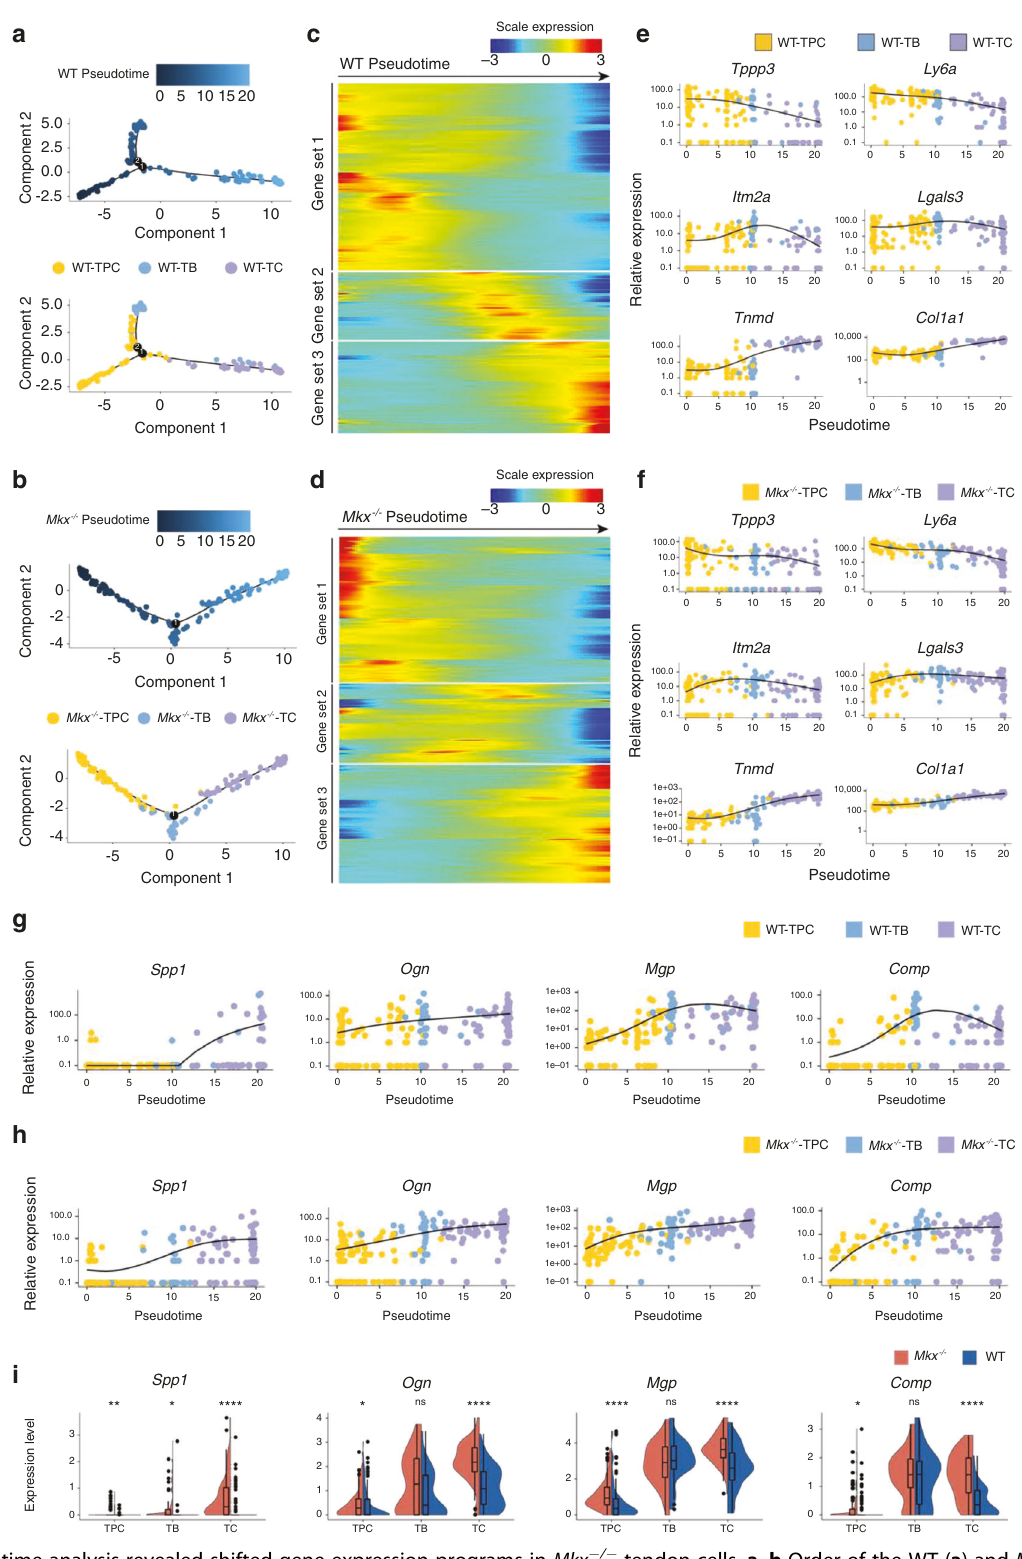
Fig. 4 Pseudotime analysis revealed shifted gene expression programs in Mkx − / − tendon cells. a , b Order of the WT ( a ) and Mkx − / − ( b ) cells along the differentiation trajectory based on pseudotime values and cell clusters. c , d Gene expression dynamics along the WT ( c ) and Mkx − / − ( d ) differentiation trajectories. Genes (row) are clustered and cells (column) are ordered according to pseudotime development. e , f Kinetic diagrams showing the expression of early, middle and late tenogenesis markers during the differentiation of WT ( e ) and Mkx − / − ( f ) cells. g , h Kinetic diagrams showing the expression of osteochondrogenic markers during the differentiation of WT ( g ) and Mkx − / − ( h ) cells. i Violin plots showing the Spp1, Ogn , Mgp , and Comp expression in wild-type and Mkx − / − TPCs, TBs, and TCs. ns no signi fi cance; * P < 0.05; ** P < 0.01; **** P < 0.000 1. TPCs tendon progenitor cells, TBs tenoblasts, TCs